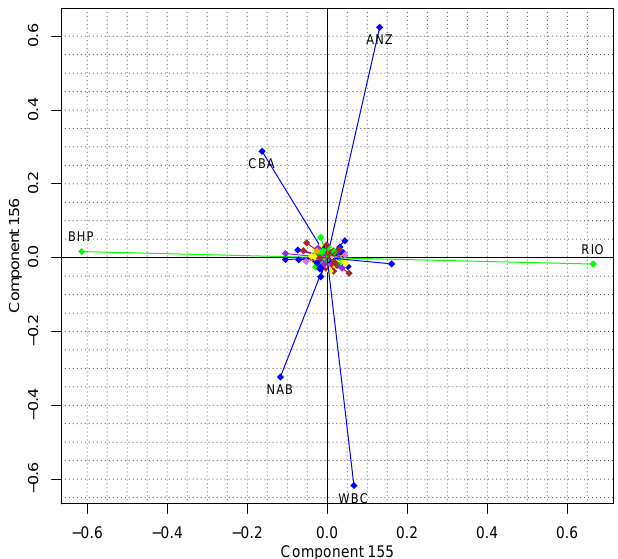
Figure 3. Scatter plots of relative weights of each stock in components 155 and 156 arising from a PCA on a correlation matrix from the whole study period. The lines join the origin to the point representing the coefficient in the 155th eigenvalue ( x -axis) and 156th eigenvalue ( y -axis). The stocks are colour-coded using the colour scheme described in Figure 1. Stocks with a loading of at least 0.2 in one of the PCs are labelled with their ticker symbol. From this scatterplot, we can conclude that there are six highly correlated stocks structured as three pairs: namely, CBA and WBC, NAB and ANZ, and BHP and RIO.